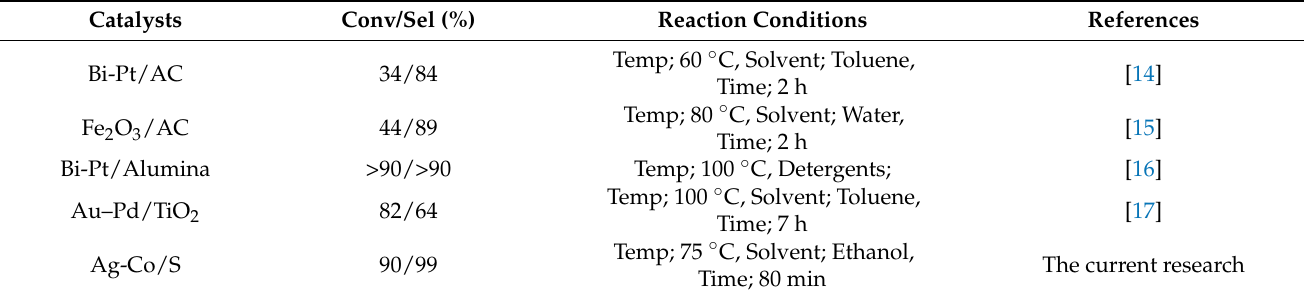
Table 1. Comparative study of the catalytic performance of our synthesized nanoparticles to that reported in the literature for the oxidation of CA to